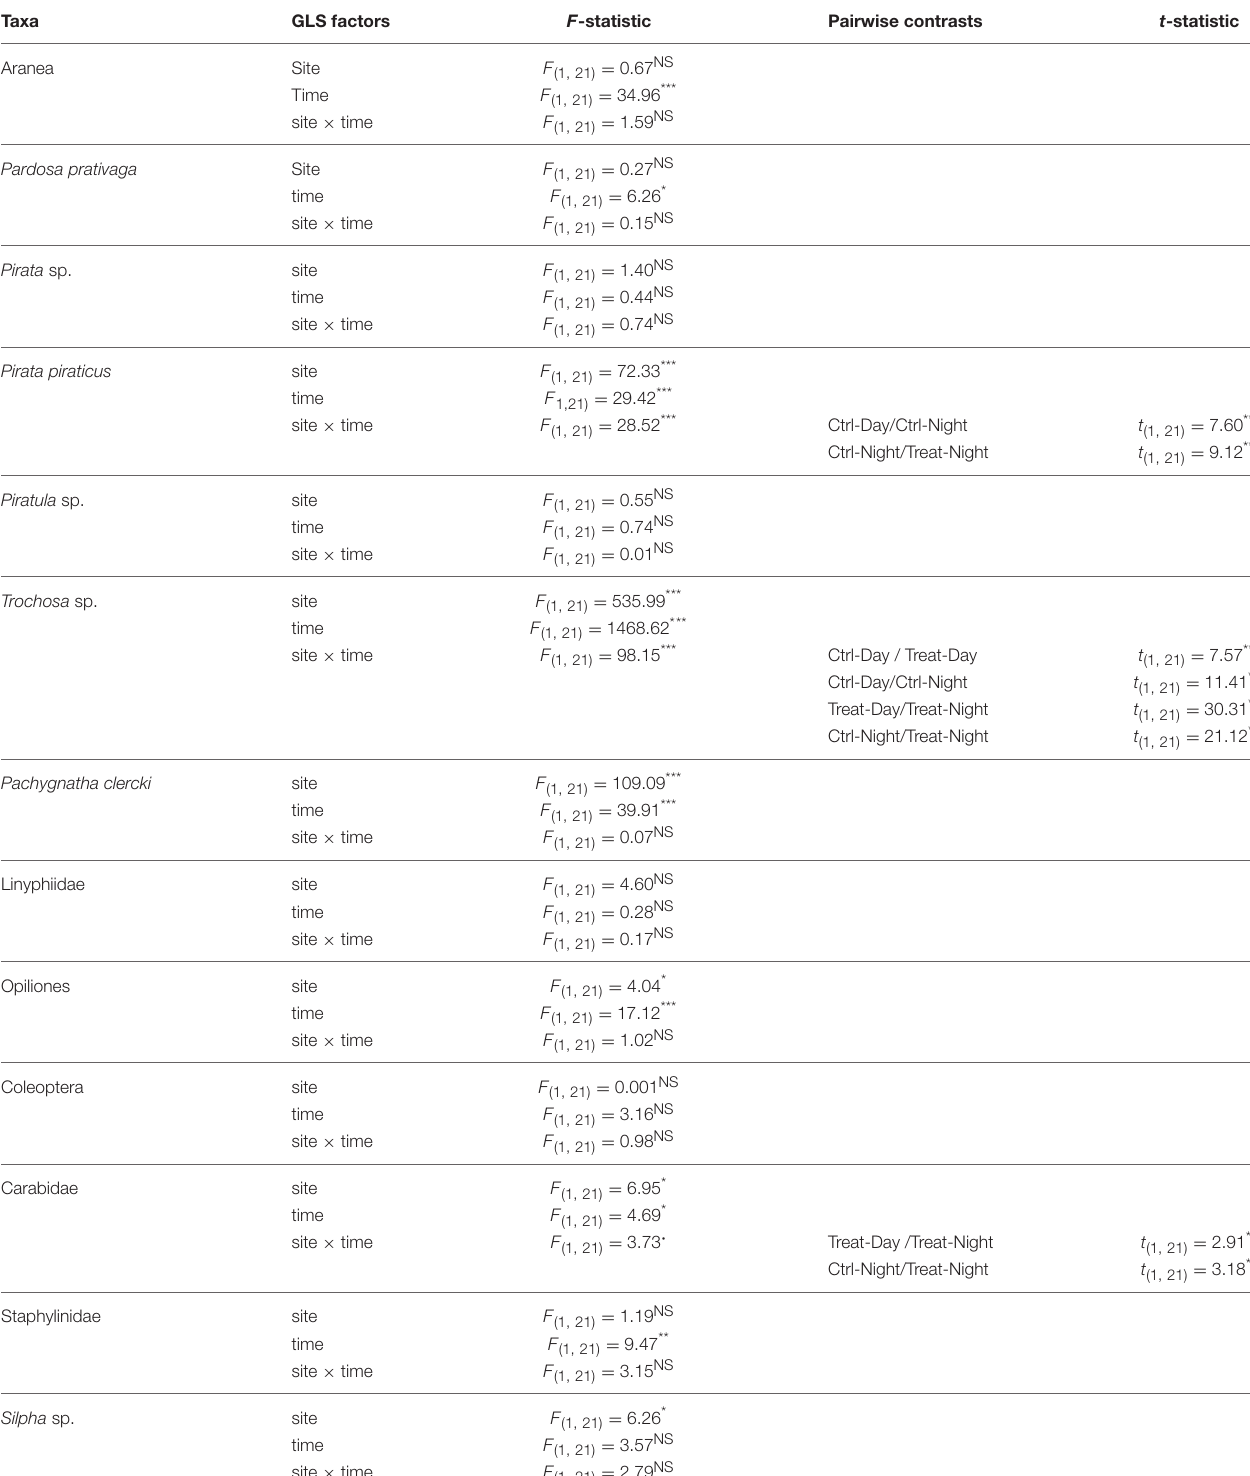
TABLE 3 | Arthropod abundance (CPUE) was compared to assess circadian activity of ground-dwelling secondary consumers. Taxa GLS factors F -statistic Pairwise contrasts t